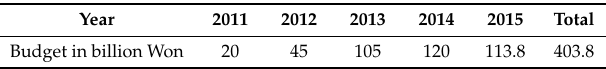
Table 1. Budget of PAL-XFEL Project.